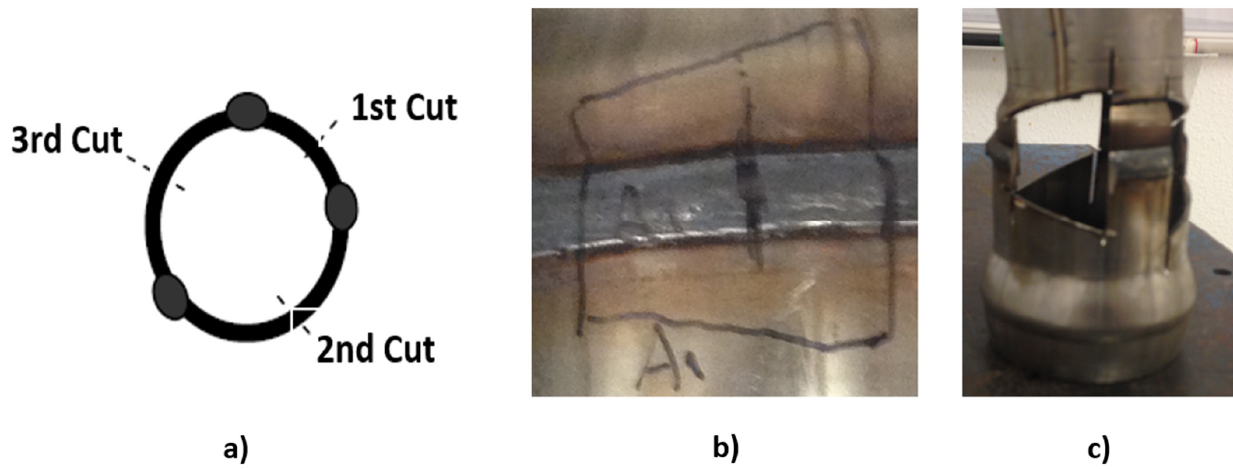
Figure 4. ( a ) Schematic representation of the cuts in a circular weld bead, ( b ) marking the area to be cut, and ( c ) cut tube. In the next step, the samples were polished in an LS1 remate polishing machine using sandpapers with 180, 320, and 600 grits. Finally, a chemical attack was carried out for better visualization of the cutting region of the weld bead. For the chemical attack, a solu- tion of hydrochloric acid with nitric acid was used in a proportion of 1:10. Once this task was completed, 45 samples were obtained out of a possible 54. Some samples were discarded due to imperfections.